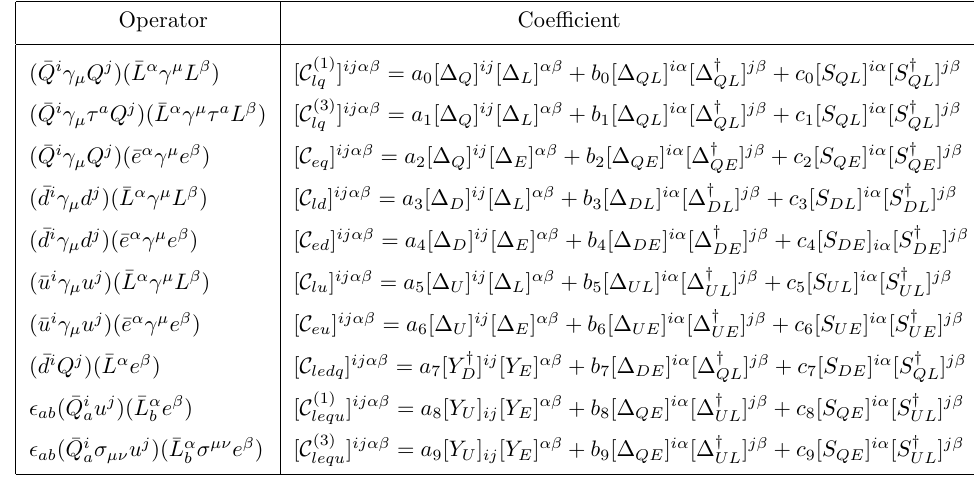
Table 3 . Decomposition of the 4-fermion SMEFT (cid:13)avour coe(cid:14)cients in terms of spurions. Here we did not list higher orders in the spurion expansion that could be induced by radiative